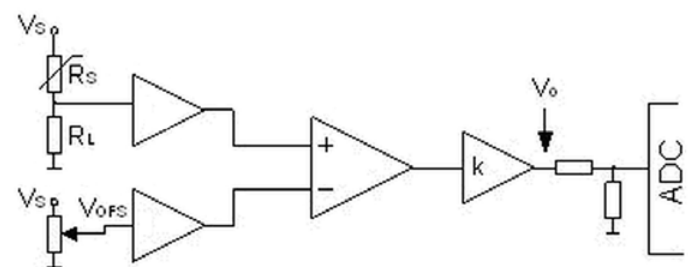
Figure 2. Scheme of integrated